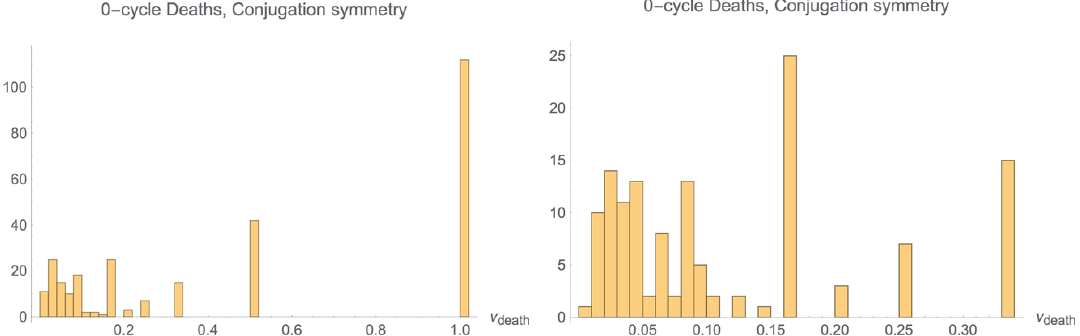
Figure 9 . For rigid Calabi-Yau vacua with a low energy symmetry descending from complex conjugation, the topological complexity of the distribution is reduced. As the points live on a line, there are only 0-cycles. Long-lived 0-cycles correspond to vacua at the centers of voids in the full